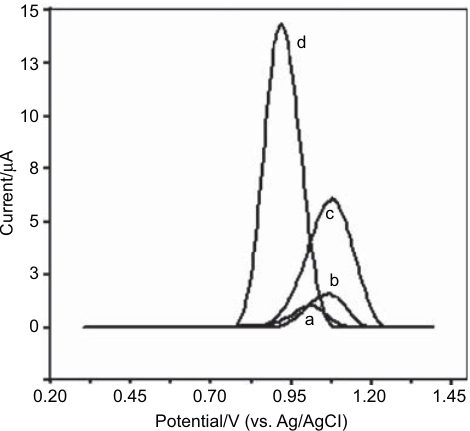
Figure 3 SW voltammograms at different pH values: (a) Britton- Robinson buffer pH 6.0, (b) Tris buffer pH 7.0, (c) Britton-Robinson buffer pH 9.0, and (d) phosphate buffer pH 12.0. TU concentration: 65.5 µ M . SWV conditions: pulse amplitude, 25 mV, frequency, 25 Hz, step potential, 8 mV.